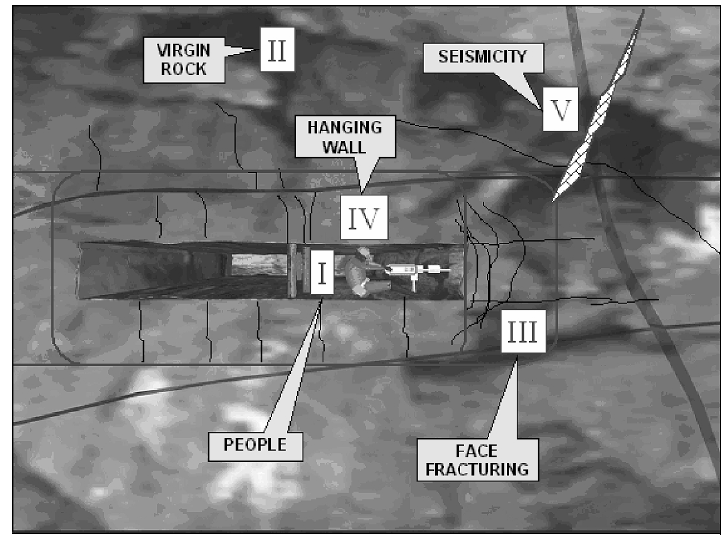
Fig. 1. Cross-section of an underground stope and surrounding hard rock (figure courtesy of S. Spottiswoode, used with permission). The various zones shown above associated with the underground mining environment are described as follows: Zone I is the excavation where mining takes place, Zone II is the virgin rock, Zone III is the highly fractured zone ahead of the stope face that could extend to 20 m, Zone IV is the hangingwall, Zone V is the seismogenic region in the